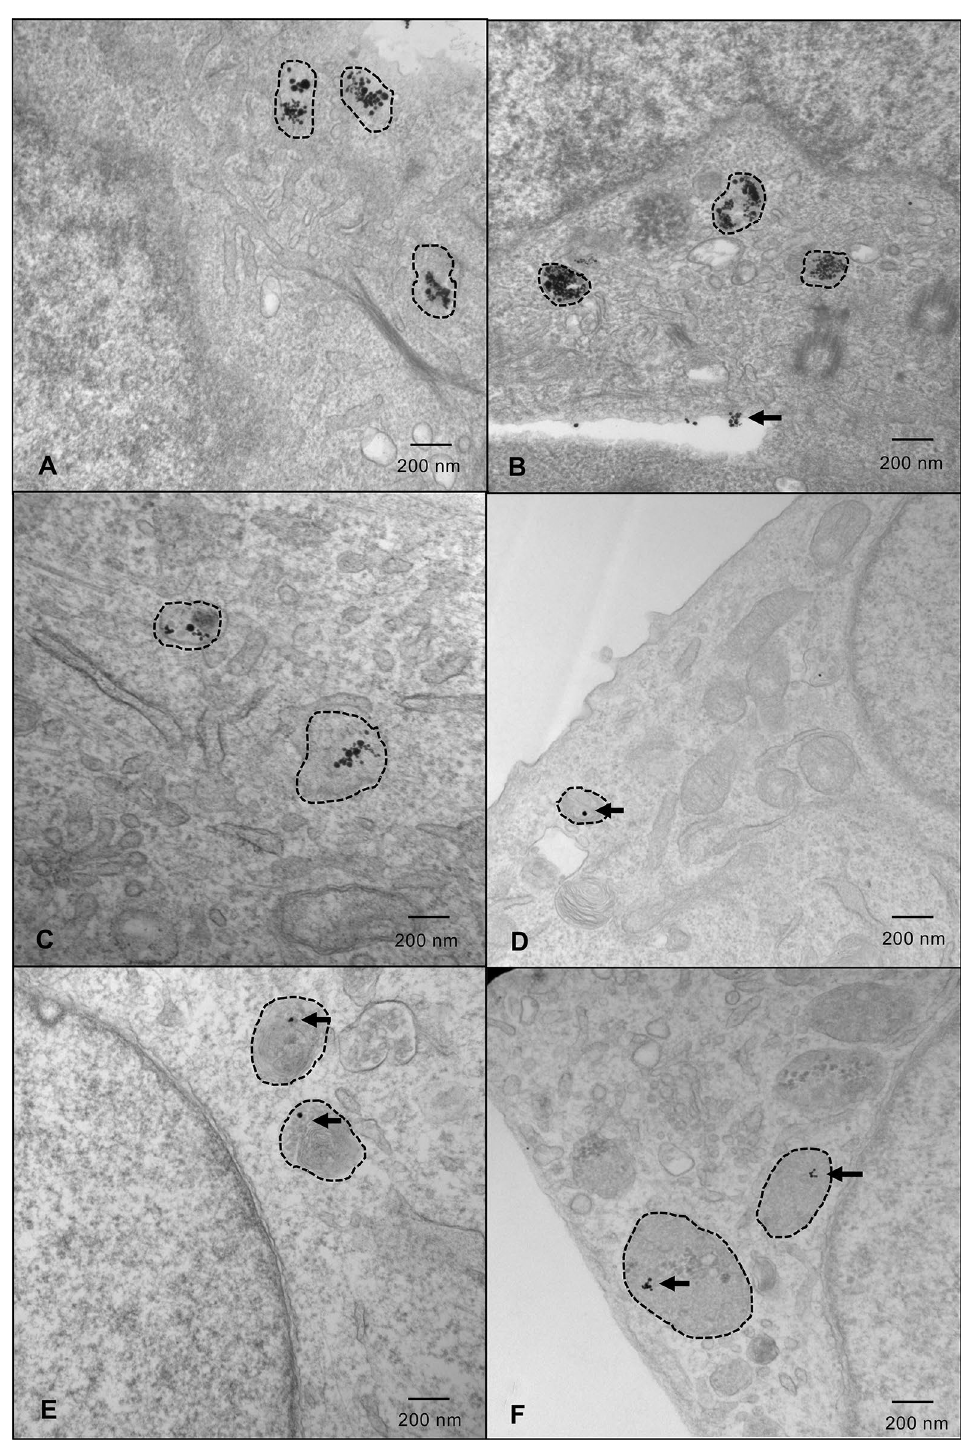
Figure 1. HNC cells demonstrate the greatest uptake of GNPs in lysosomes. Representative images of cells labelled with 25 µM GNPs. Lysosomes are indicated with hashed outlines. ( a ) FaDu; ( b ) HSC-3; ( c ) Detroit-562; ( d ) SK-N-AS; ( e ) Panc1; and ( f ) A673 cells. Cells were fixed approximately 36 h after GNP-labelling (approximate radiation timepoint) and images were captured by a transmission electron microscope. Imaging was done in triplicate—5 images were captured for each sample, with 3 samples/replicate, and 3 replicates in total. HNC head and neck cancer, GNPs gold